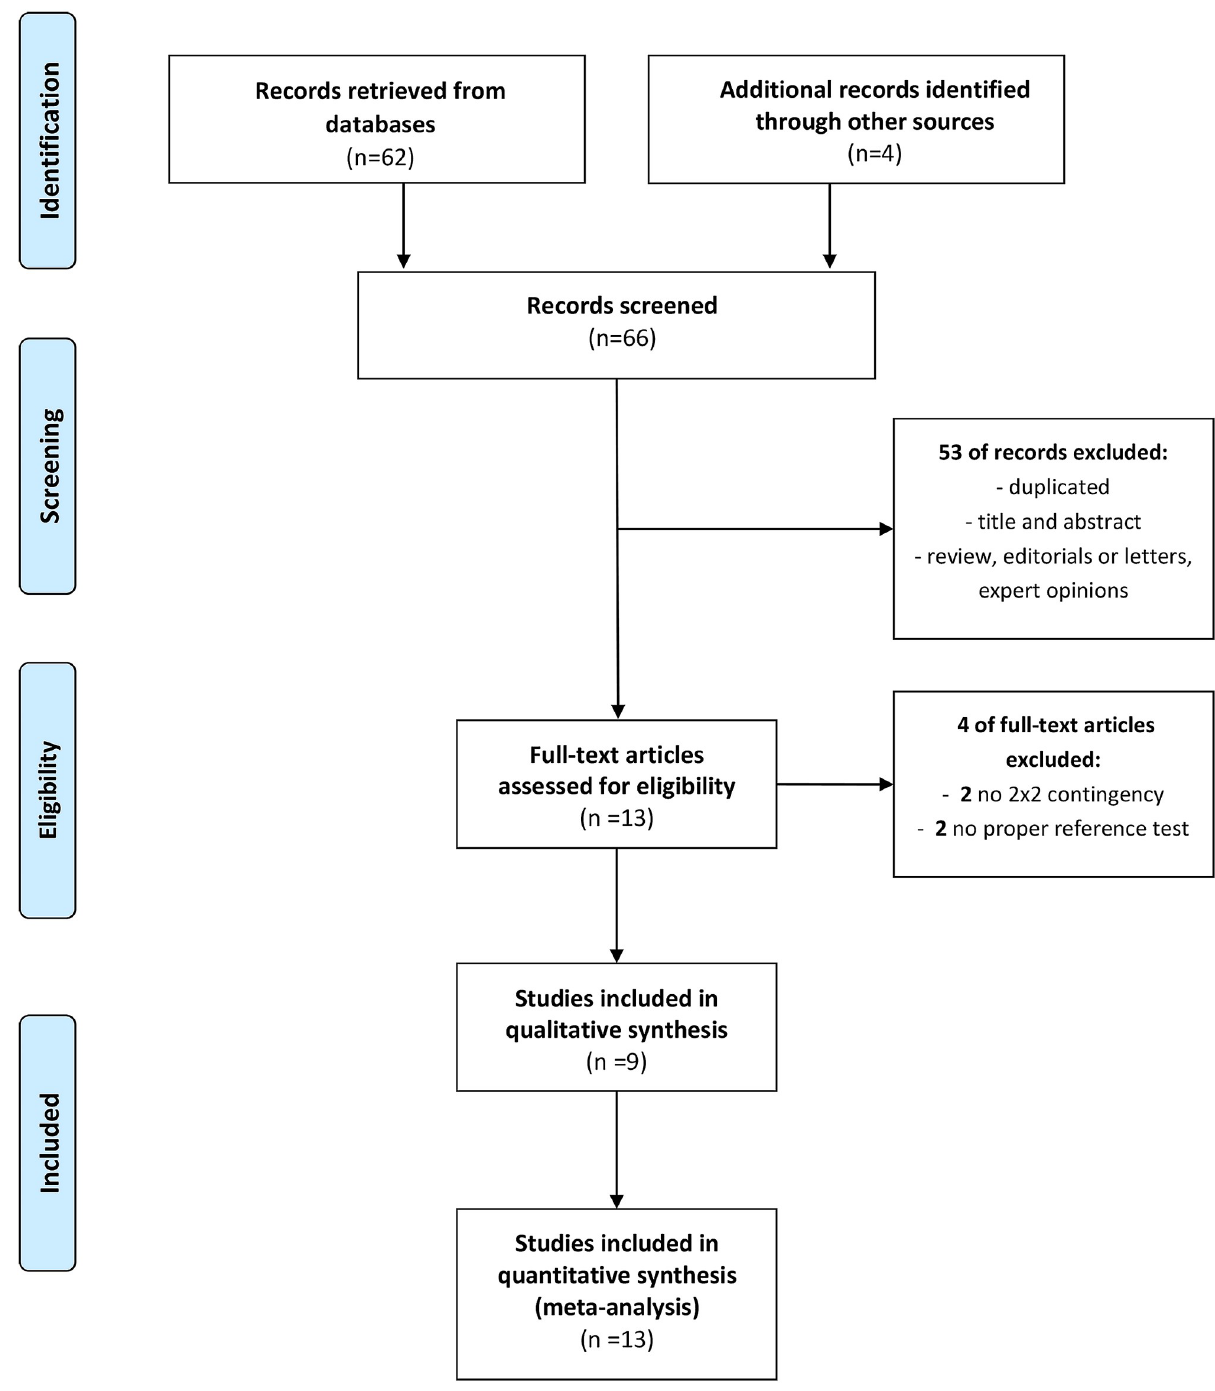
Fig 1. Preferred Reporting Items for Systematic Reviews and Meta-Analyses (PRISMA) flow chart of the selection process used for eligible studies.